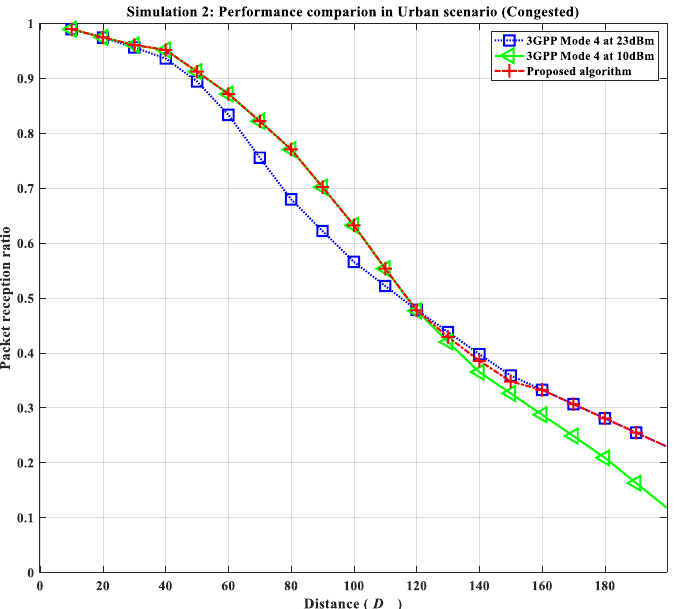
Figure 10. Packet reception ratio as a function of the distance between the transmitter and receiver ( D xy ) in an urban scenario with congested tra ffi c.